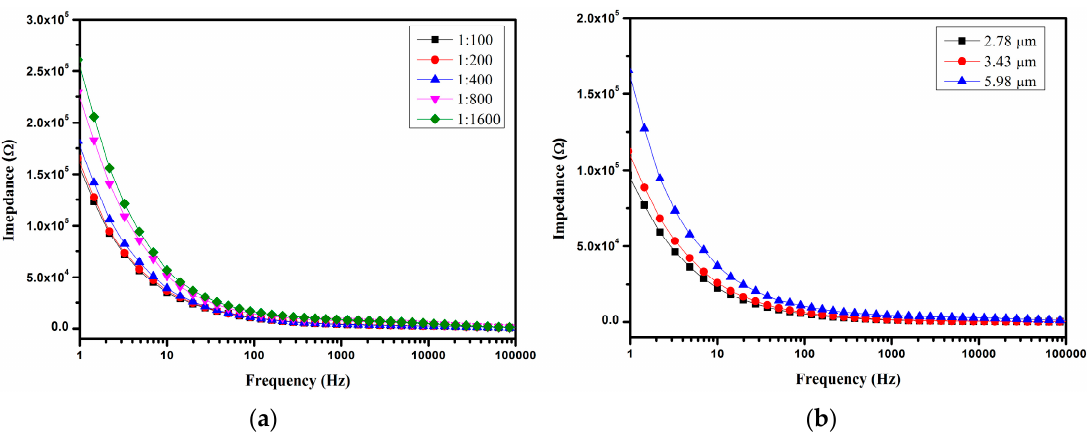
Figure 7. Impedance measurements of different volume ratios of solutions containing 5.98 µm polystyrene microspheres ( a ) and solutions containing different diameters of polystyrene microspheres ( b ). Different diameters of polystyrene microspheres were diluted in 0.6 M NaCl solution with the same volume ratio of 1:200.